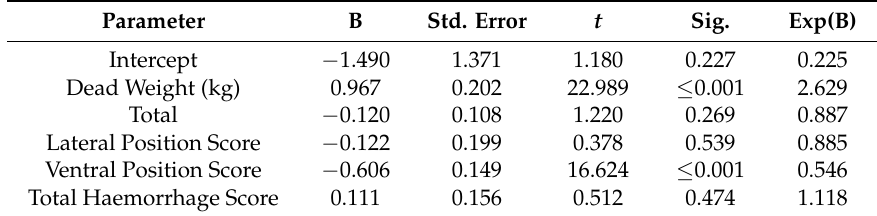
Figure 6. The effect of dead weight on time to loss of movement in lambs. Table 3. The parameter estimates from a binary logistic regression testing the effect of variables on movement scores of 2 or 3. The regression was coded with the score of 3 as the positive (logistic)